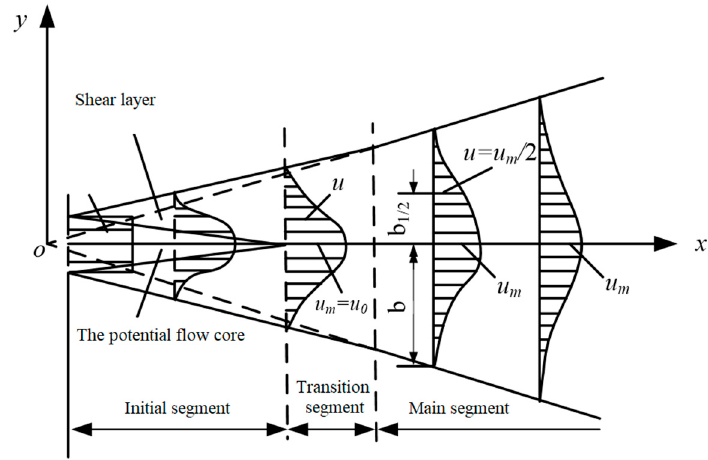
Figure 4. The flow characteristics of free turbulence jet.